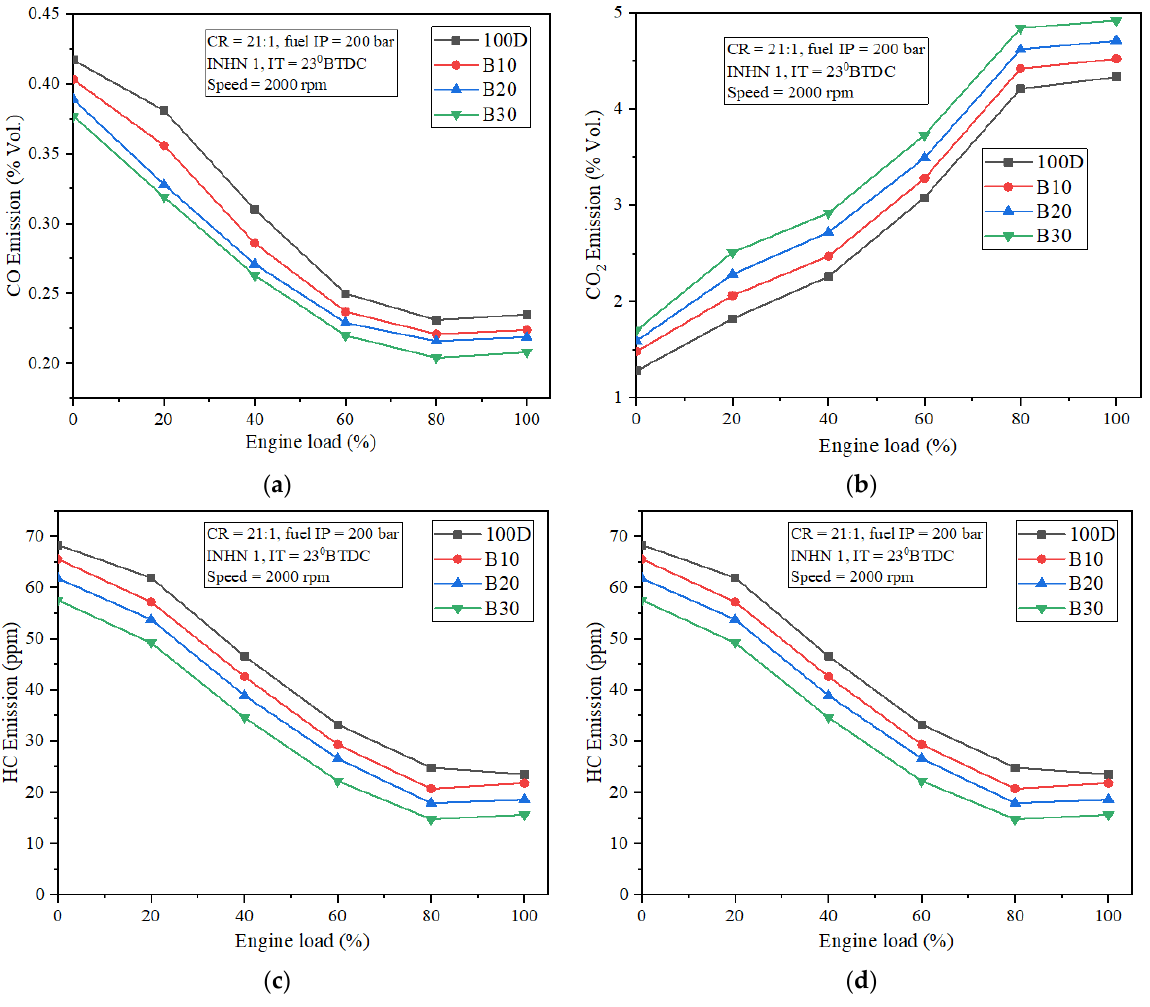
Figure 15. Influence of engine load on ( a ) CO; ( b ) CO 2 ; ( c ) HC; ( d ) NOx emissions from engine.